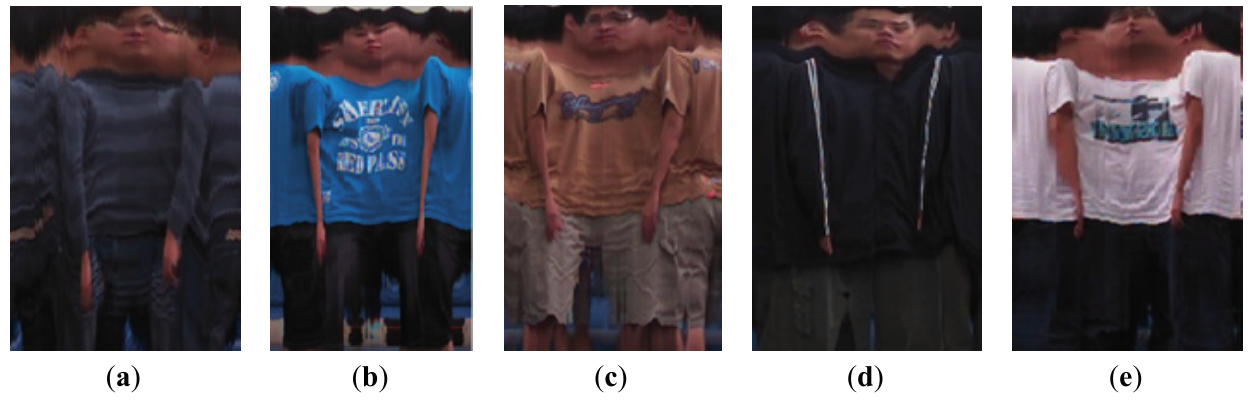
Figure 10. Constructed FCTs of five adult males with similar body builds.